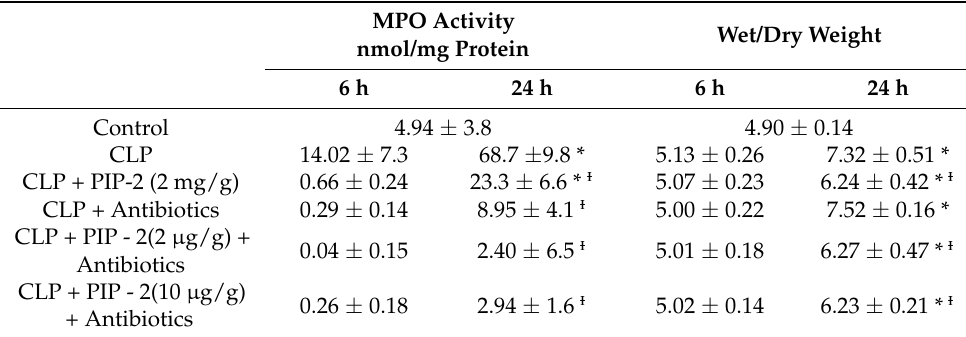
Table 4. Indices of lung MPO activity and lung W/D at 6 h and 24 h after CLP. MPO